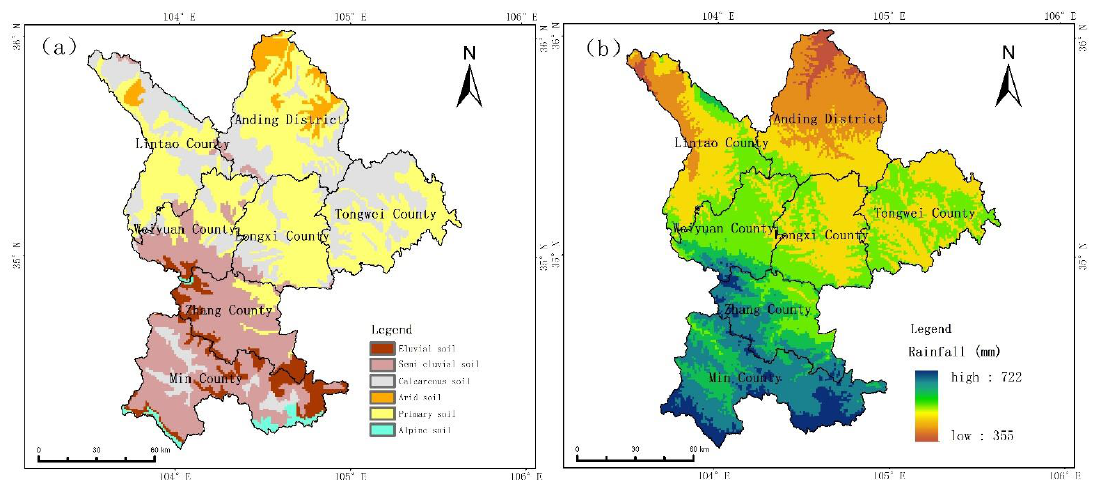
Figure 2. ( a ) Soil types and ( b ) average precipitation from 1980 to 2015.